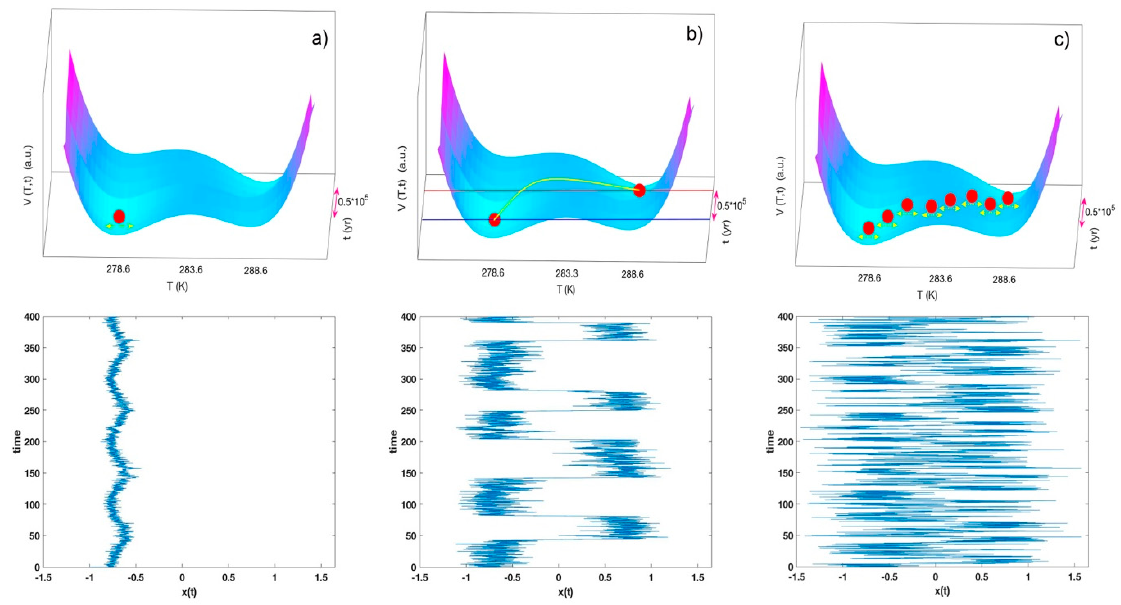
Figure 10. Solution of Equation (19) for a = 0.3 and α = 0.10, 0.19, 0.40, 0.55. For α = 0.10, the system is confined in the left well ( a ) while for α = 0.19 it jumps to the right well ( b ). For α = 0.40 and α = 0.55, the resonance efficiency decreases ( c ).